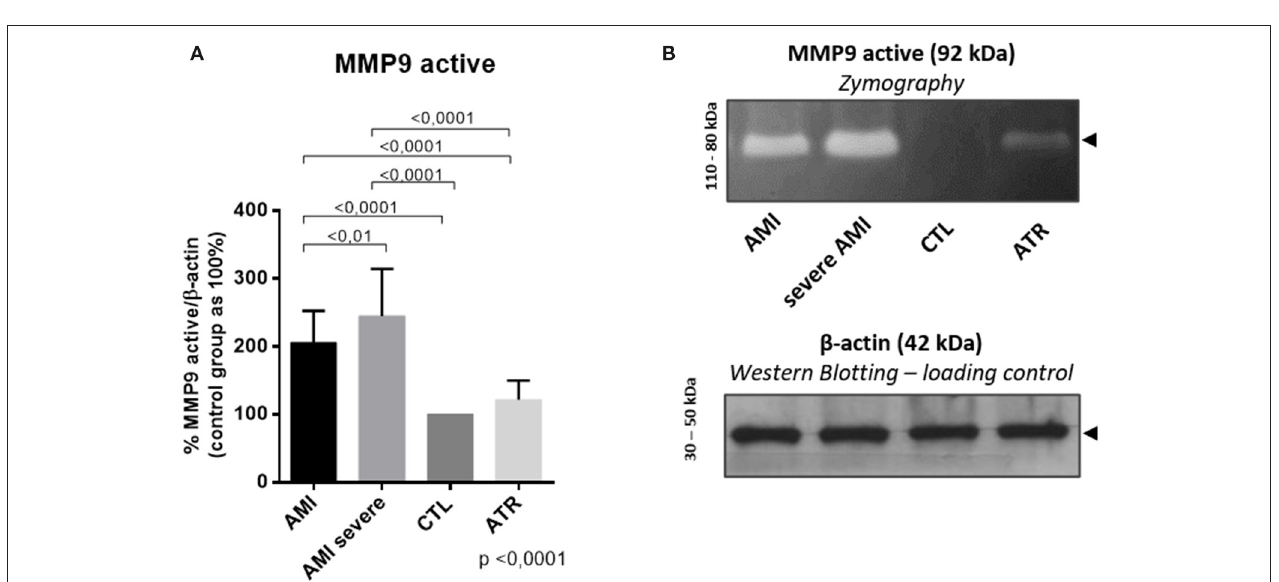
FIGURE 4 | Analysis of the enzymatic activity of MMP9 through gelatin Zymography. There is positive regulation of the catalytic activity of MMP9 in infarcted patients, and the severity accentuates the activation. (A) Quantification of active MMP9 (%), with the control group set to 100% ( n = 34. per group). (B) Representative gel of MMP9 activity in the study groups. β -actin is used as a loading control. (Data are expressed as the mean ± standard deviation). Comparison by ANOVA with Tukey applied as a